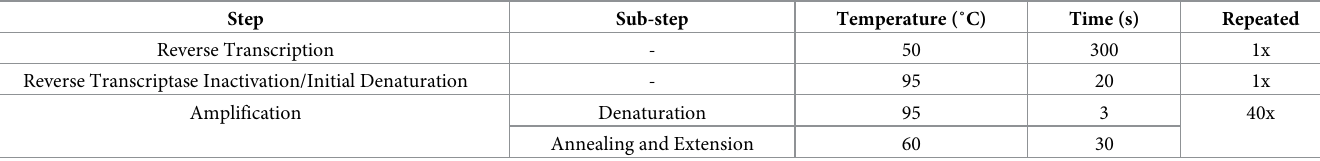
Then, samples were fixed and permeabilized using the Cytofix/Cytoperm Kit (BD Biosciences) according to the manufacturer’s instructions. Samples were incubated for 30 minutes at 4˚C with antibody against DENV envelope protein (clone 4G2, FITC, Millipore). Samples were run on an LSRII (BD) and data were analyzed using FlowJo (TreeStar). Determination of megakaryocyte differentiation status. Cells differentiated from human CD34 + cells were blocked with normal mouse serum (Invitrogen) for 10 minutes at room tem- perature. Samples were incubated for 30 minutes at 4˚C with antibodies against human CD34 (clone 581, AF700, Biolegend), human CD41a (clone HIP8, PE, Biolegend), human CD42b (clone HIP1, FITC, Biolegend), and human CD62L (clone AK4, AF647, Biolegend) diluted in megakaryocyte buffer. Samples were run on an LSRII (BD) cytometer and data were analyzed using FlowJo (TreeStar). Cells that were CD41a + CD42b - were considered immature megakaryo- cytes and cells that were CD41a +/- CD42b + were considered mature megakaryocytes. Determination of putative DENV receptors on UT-7 cells. UT-7 cells were blocked with normal mouse serum (Invitrogen) for 10 minutes at room temperature. Samples were singly incubated for 30 minutes at 4˚C with antibody against human CD206 (clone 19.2, PE, BD Bio- sciences), human DC-SIGN (clone 120507, AF647, R&D Systems), human DC-SIGNR (clone human CD300a (MEM260, AF647, BD Biosciences), human TIM1 (clone 219211, AF700, Novus Biologicals), or Tyro3 (polyclonal, AF405, Novus Biologicals) diluted in PBS/FBS. Sam- ples were run on an LSRII (BD) cytometer and data were analyzed using FlowJo (TreeStar). Determination of UT-7 infection status and viability. UT-7 cells were stained with Ghostdye UV450 (Tonbo) per the manufacturer’s instructions. Cells were blocked with nor- mal mouse serum (Invitrogen) for 10 minutes at room temperature. Then, cells were fixed and permeabilized using the Cytofix/Cytoperm kit (BD Biosciences) according to the manufactur- er’s instructions. Samples were then incubated for 30 minutes at 4˚C with antibody against DENV envelope (4G2, FITC, Millipore). Samples were run on an LSRII cytometer (BD) and data were analyzed using FlowJo (TreeStar). Viability was also assessed via trypan blue exclu- sion. A sample of infected UT-7 cells were collected every other day post infection and diluted in cell culture media with trypan blue (final dilution 1:10). Total cells, trypan blue stained cells, and unstained cells were counted via hemocytometer. Viable cells were those that were unstained by trypan blue. The percentage of viable cells was calculated by dividing the number of unstained cells by the number of total cells.